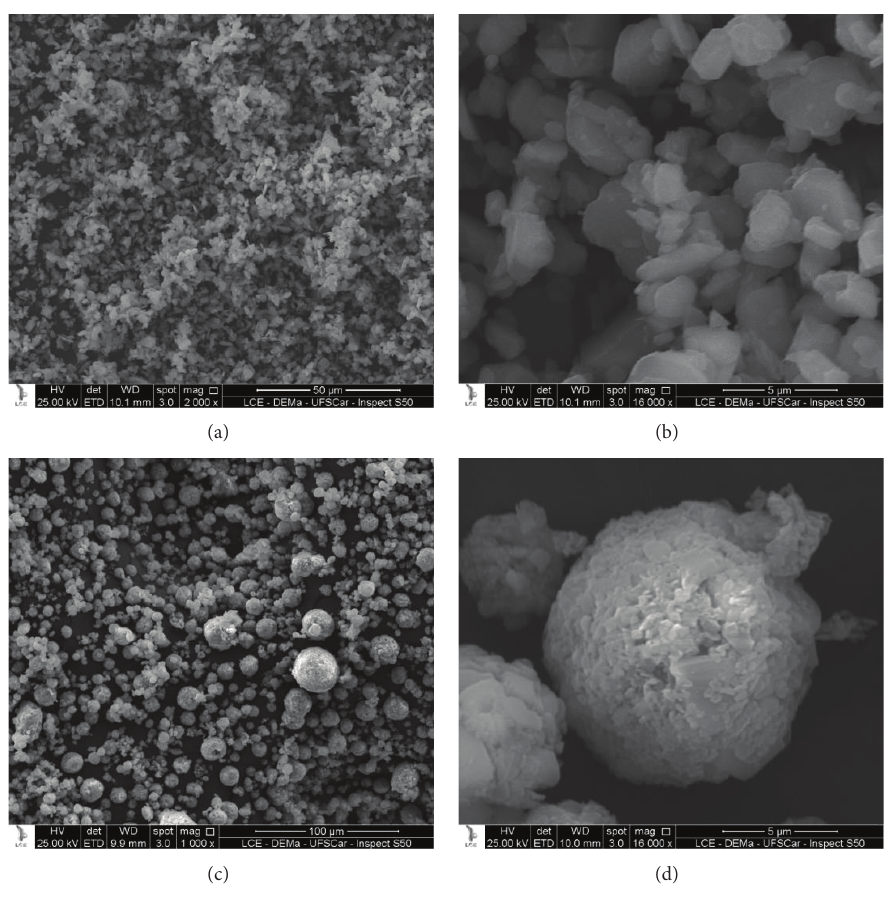
Figure 4: Scanning electron micrographs: (a) AP magnified 2,000x, (b) AP 16,000x, (c) CP 1,000x, (d) CP 16,000x.